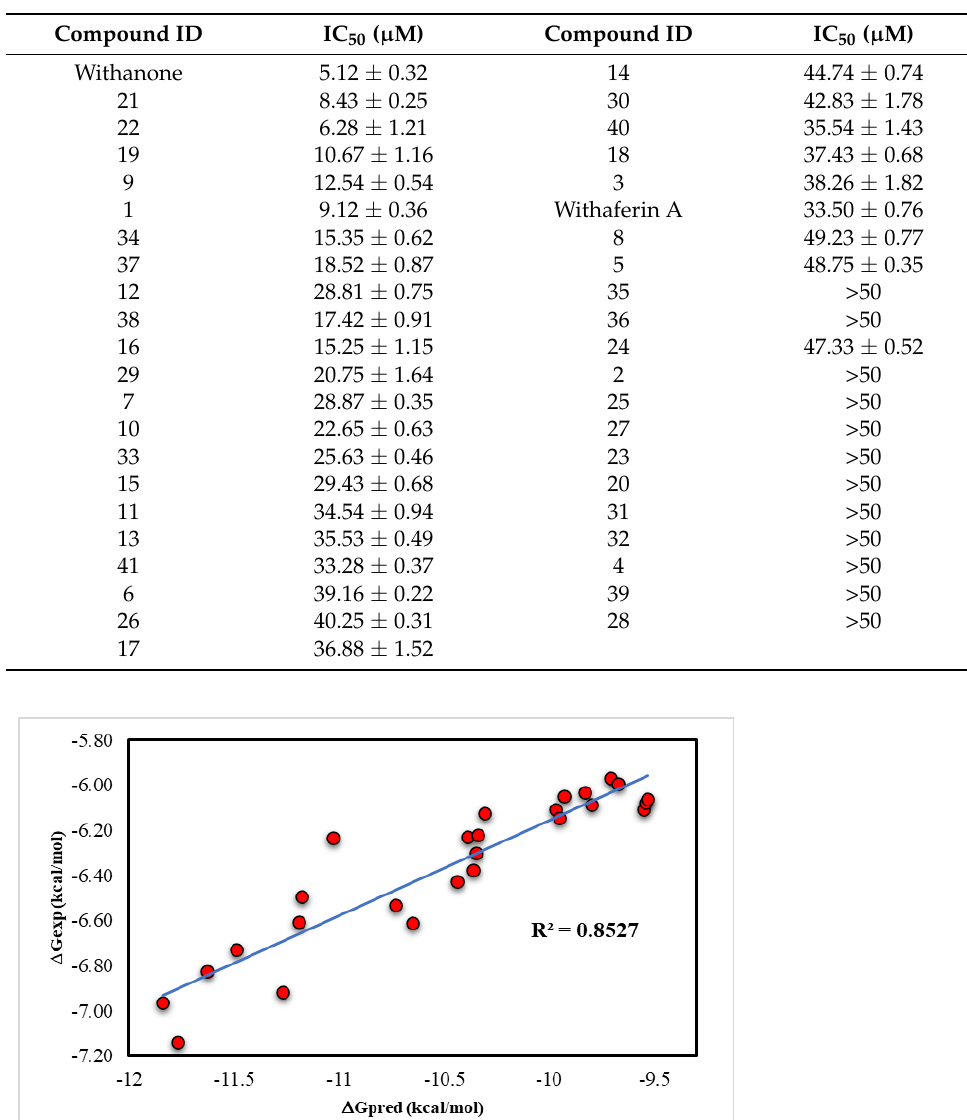
Table 4. Cytotoxic activity (IC 50 , µ M) of 41 phyto triterpenes on HepG2 cell line after 48 h of incubation.